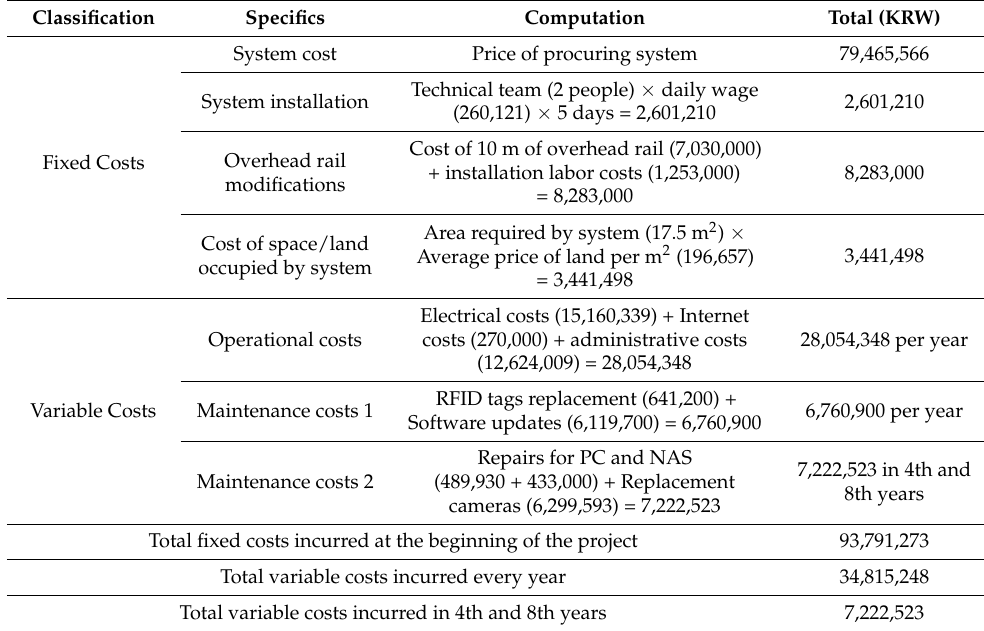
Table 1. A summary of the fixed and variable costs incurred in the